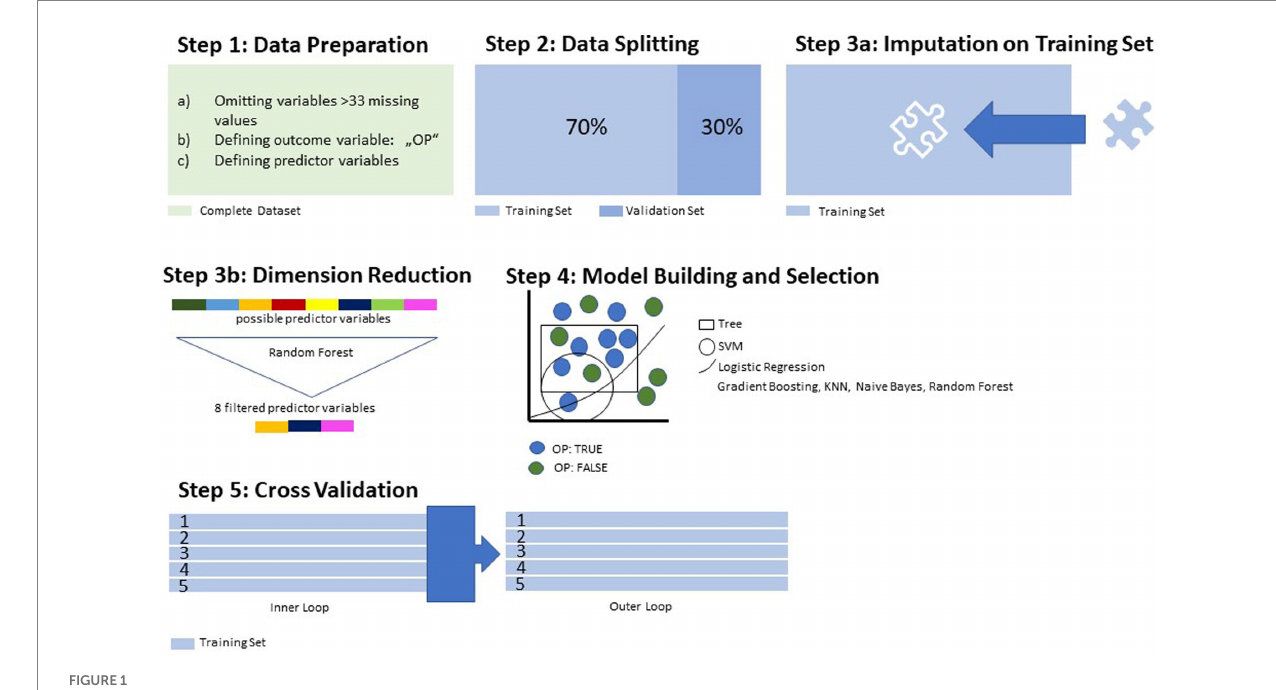
FIGURE 1 Data processing and